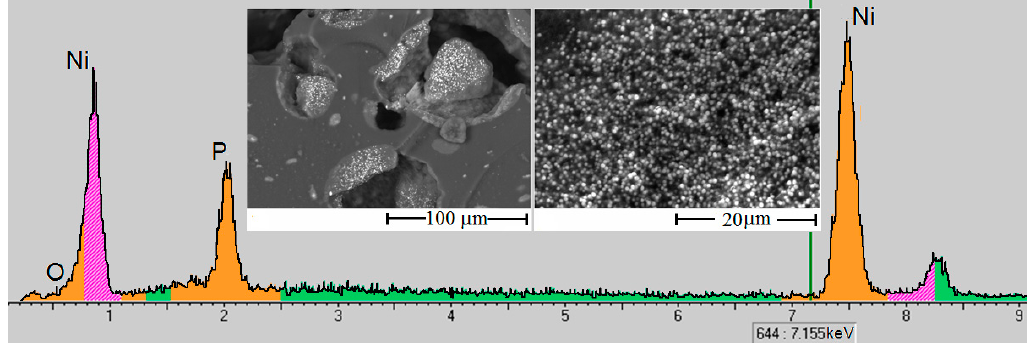
Figure 5. Scanning electron microscopy (SEM) images and energy dispersion analysis (EDA) histograms of the Ni / р HEMA-gr-PVP composite (H ЕМ A:PVP:S ORS = 80:20:25 mass parts; [NiSO 4 ] = 1.1 mol / L; pH = 4.5).